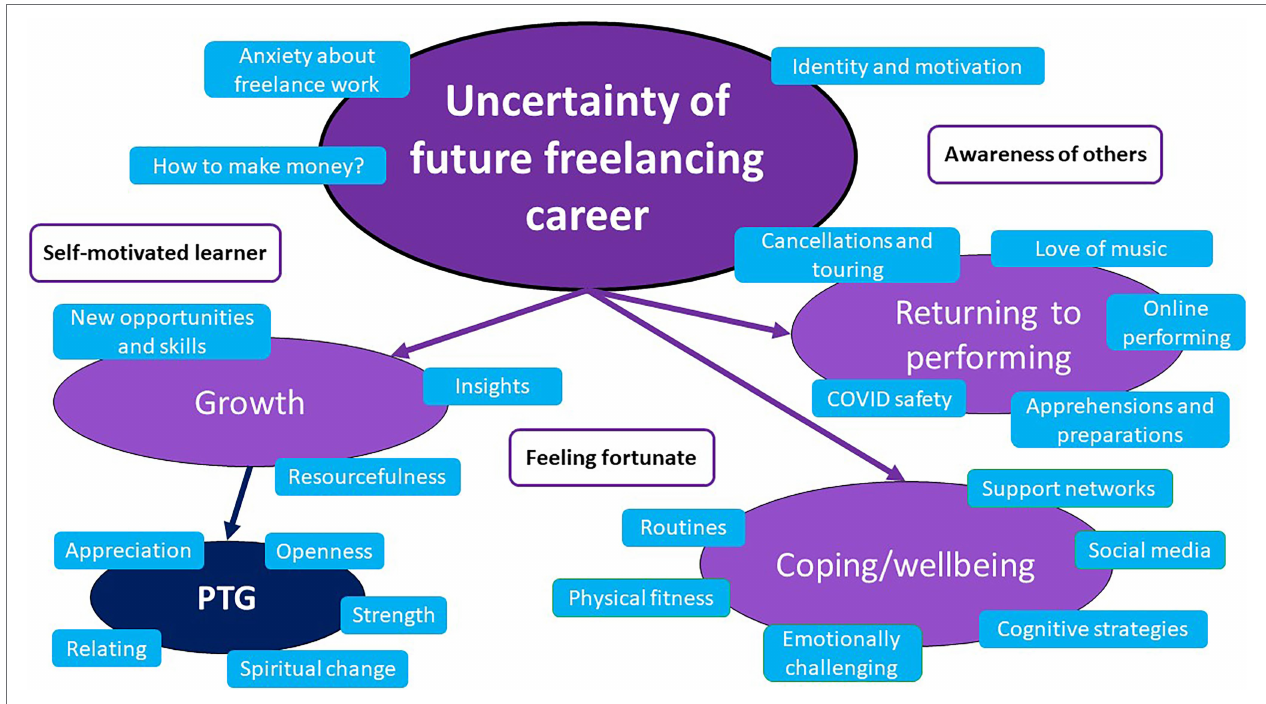
FIGURE 1 | Model of themes and